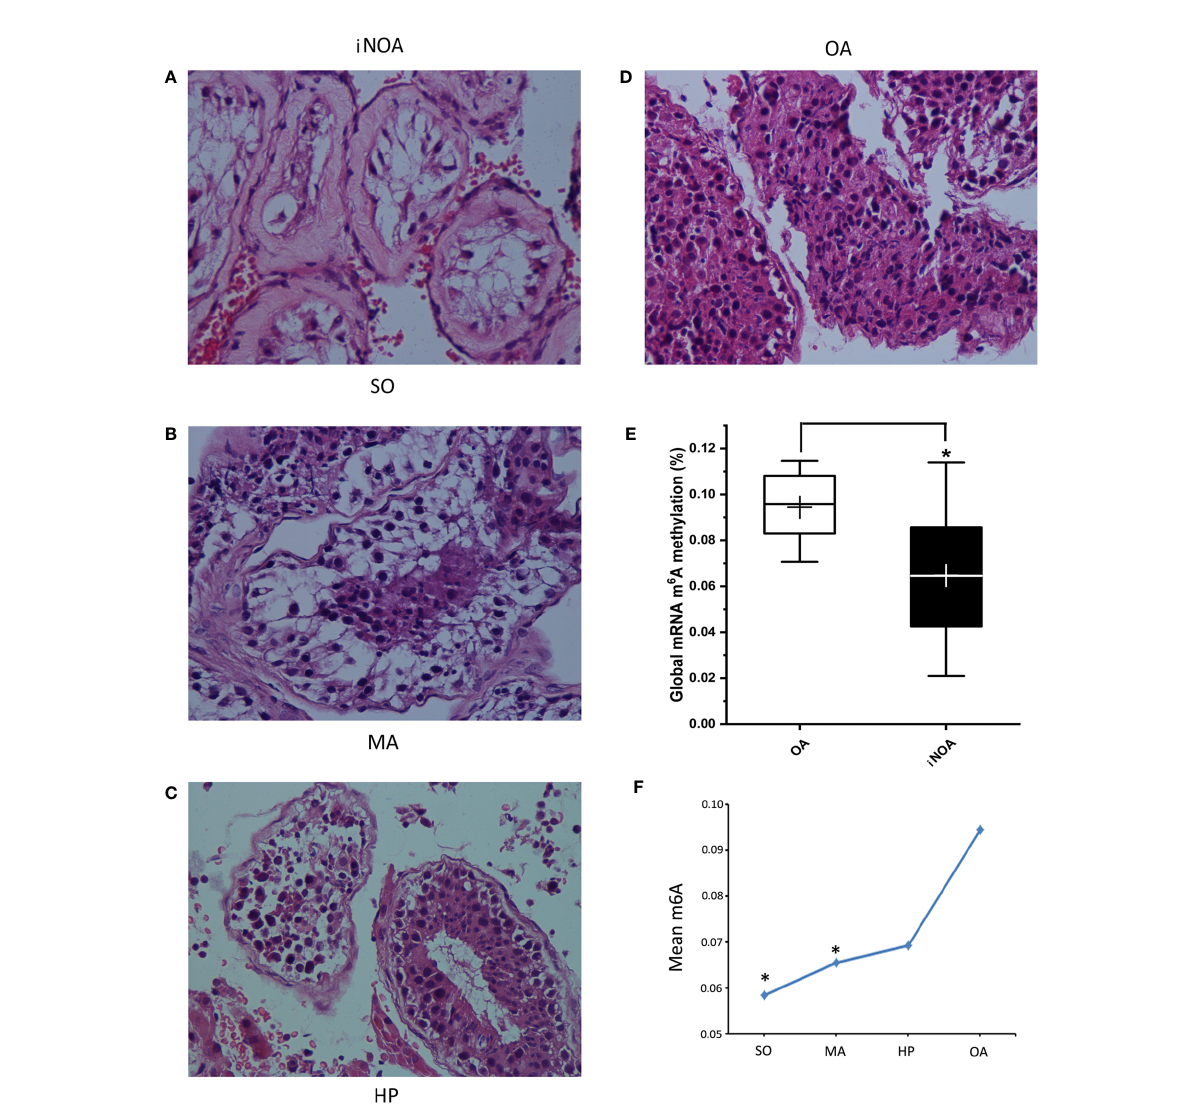
FIGURE 1 The iNOA group was divided into three groups according to the pathological types, namely the SO group (A) , the MA group (B) , and the HP group (C) . (D) shows the histology of OA. All the four representative images are 400× magni fi cations using H&E staining. (E) shows the signi fi cantly decreased global expression of m 6 A in testes tissues from iNOA groups. (F) shows the a dosage relationship between the m 6 A expression decline and the degree of impaired spermatogenesis. SO: Sertoli cell-only syndrome, MA: maturation arrest, HP: hypospermatogenesis, OA: obstructive azoospermia. * P < 0.05 compared with OA